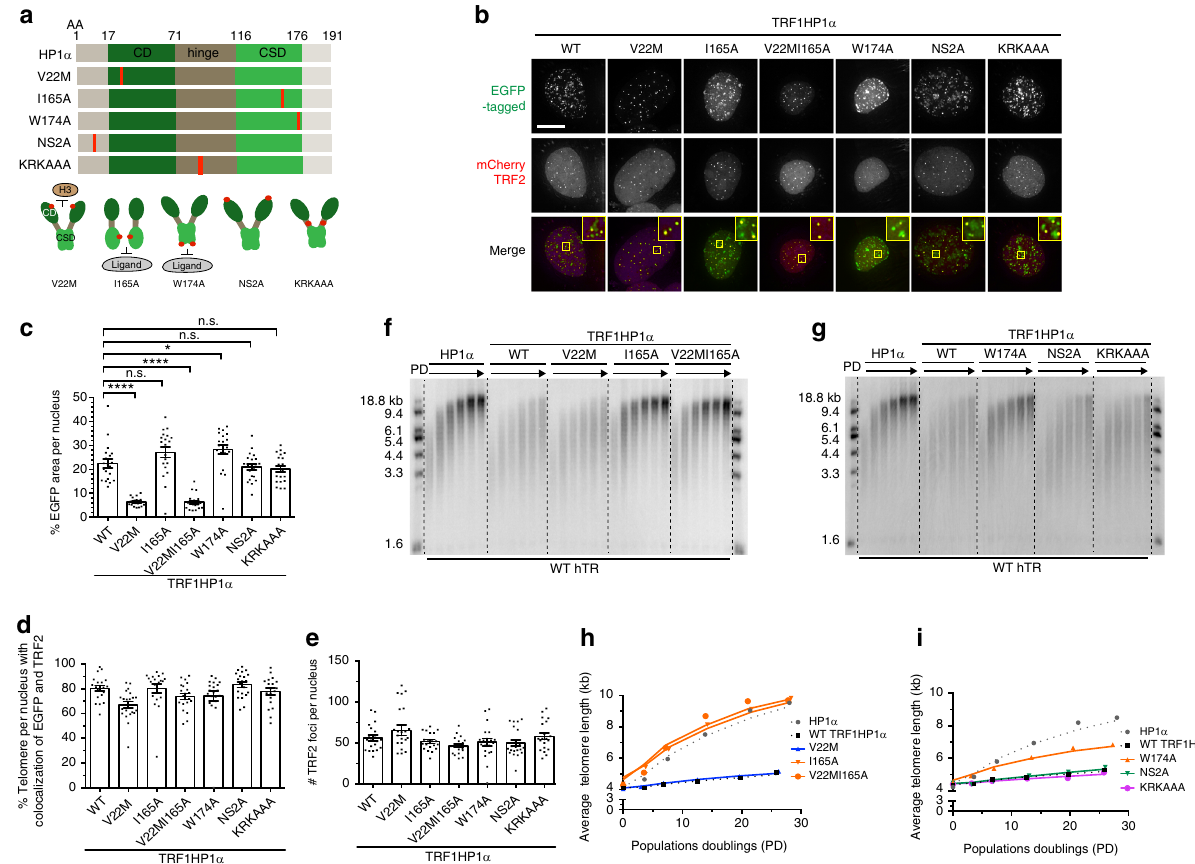
Fig. 3 Ligand binding function of HP1 α CSD controls telomere extension. a Schematic diagram of mutations in HP1 α fused to TRF1 (AA — amino acid). CD mutant V22M; CSD mutants I165A and W174A; N-terminal phosphorylation de fi cient mutant NS2A; hinge mutant KRKAAA. b Transient cotransfection of mCherry-tagged TRF2 (magenta in merged image) and various EGFP-tagged TRF1HP1 α mutants respectively in UM-UC3 cells imaged after 48 h. Scale bar: 10 µ m. ~20 nuclei were counted per group in c and d . c Quanti fi cation of % EGFP area per nucleus **** p < 0.0001; * p = 0.0260; n.s. (no signi fi cance). Signi fi cance is assessed by one-way ANOVA and Dunnett ’ s multiple comparison test with 95% con fi dence level. d Quanti fi cation of % telomeres per nucleus with colocalization of EGFP and TRF2 (mCherry). Consistently, V22M and V22MI165A show fewer total fusion protein spots per nucleus (Supplementary Fig. 4) because V22M lacks the ability to bind to other, widespread genomic regions. Thus, the slight reduction of % colocalization of V22M and V22MI165A with TRF2 is likely to be at least partially because of fewer random overlaps of telomeres with widespread HP1 α spots. e Quanti fi cation of TRF2 foci; n = ~20 nuclei per group. c − e Error bars represent s.e.m. f , g Telomere length analyses of TRF1HP1 α , WT or HP1 α mutant variants with WT hTR overexpression across PD0 to ~PD30. h , i Quanti fi cations (average telomere length) show CSD mutants I165A, W174A or double mutant V22MI165A revert the telomere extension attenuation phenotype of TRF1HP1 α . Similar fi ndings were observed in two independent (v) hinge mutant KRKAAA 36,41 , de fi cient in HP1 α DNA / RNA interaction (Fig. 3a).